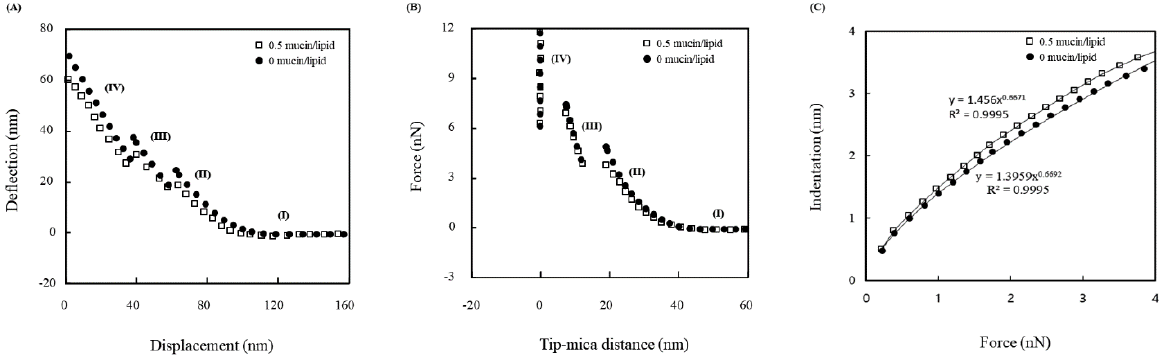
Figure 3. ( A ) Deflection with respect to displacement ( z position) for vesicle at 0% mucin; ( B ) force with respect to distance based on the data in ( A ); ( C ) indentation with respect to load force based on the region ( Ⅱ ) data of ( A , B ). Open square is for 0.5 mucin/lipid, and closed circle is for 0 mucin/lipid.